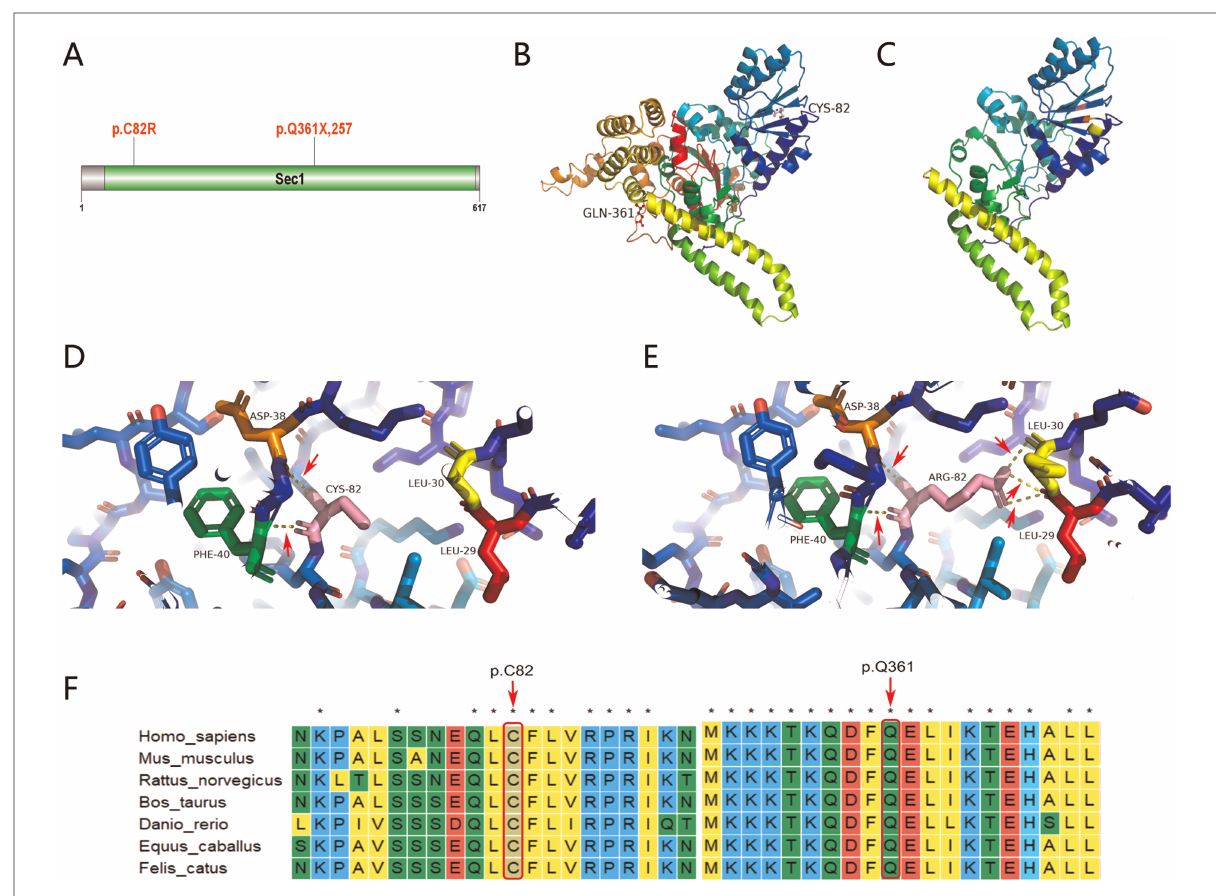
FIGURE 3 Genetic analysis and illustration of the heterozygous c1081C>T and c.244T>C mutation of VPSS33B gene. ( A ) VPS33B protein secondary structure; p .Q361X, 257 and p .C82R are located in the Sec1 domain. ( B ) VPS33B protein 3D structure (wild-type global image): Gln361(red) and Cys82 (pink). ( C ) VPS33B protein 3D structure (mutant global image); termination of amino acid translation at position 361 of VPS33B protein, resulting in the loss of 257 amino acids and truncated protein. ( D ) VPS33B protein 3D structure (wild-type local image); Cys82 (pink) forms a hydrogen bond with Leu29 (red) and Leu30 (yellow); the red arrow points to the hydrogen bond (yellow dotted line). ( E ) VPS33B protein 3D structure (mutant local image); Arg82 (pink) forms a hydrogen bond with Leu29 (red), Leu30 (yellow), Asp38 (orange), and Phe40 (green), respectively; the red arrow points to the hydrogen bond (yellow dotted line). Compared with the wild type, the number of hydrogen bonds has increased and the protein conformation has changed. ( F ) Conservation analysis of VPS33B protein; Gln361 and Cys82 are located in the highly conserved amino acid region, and the conserved amino acid mutation may damage the protein